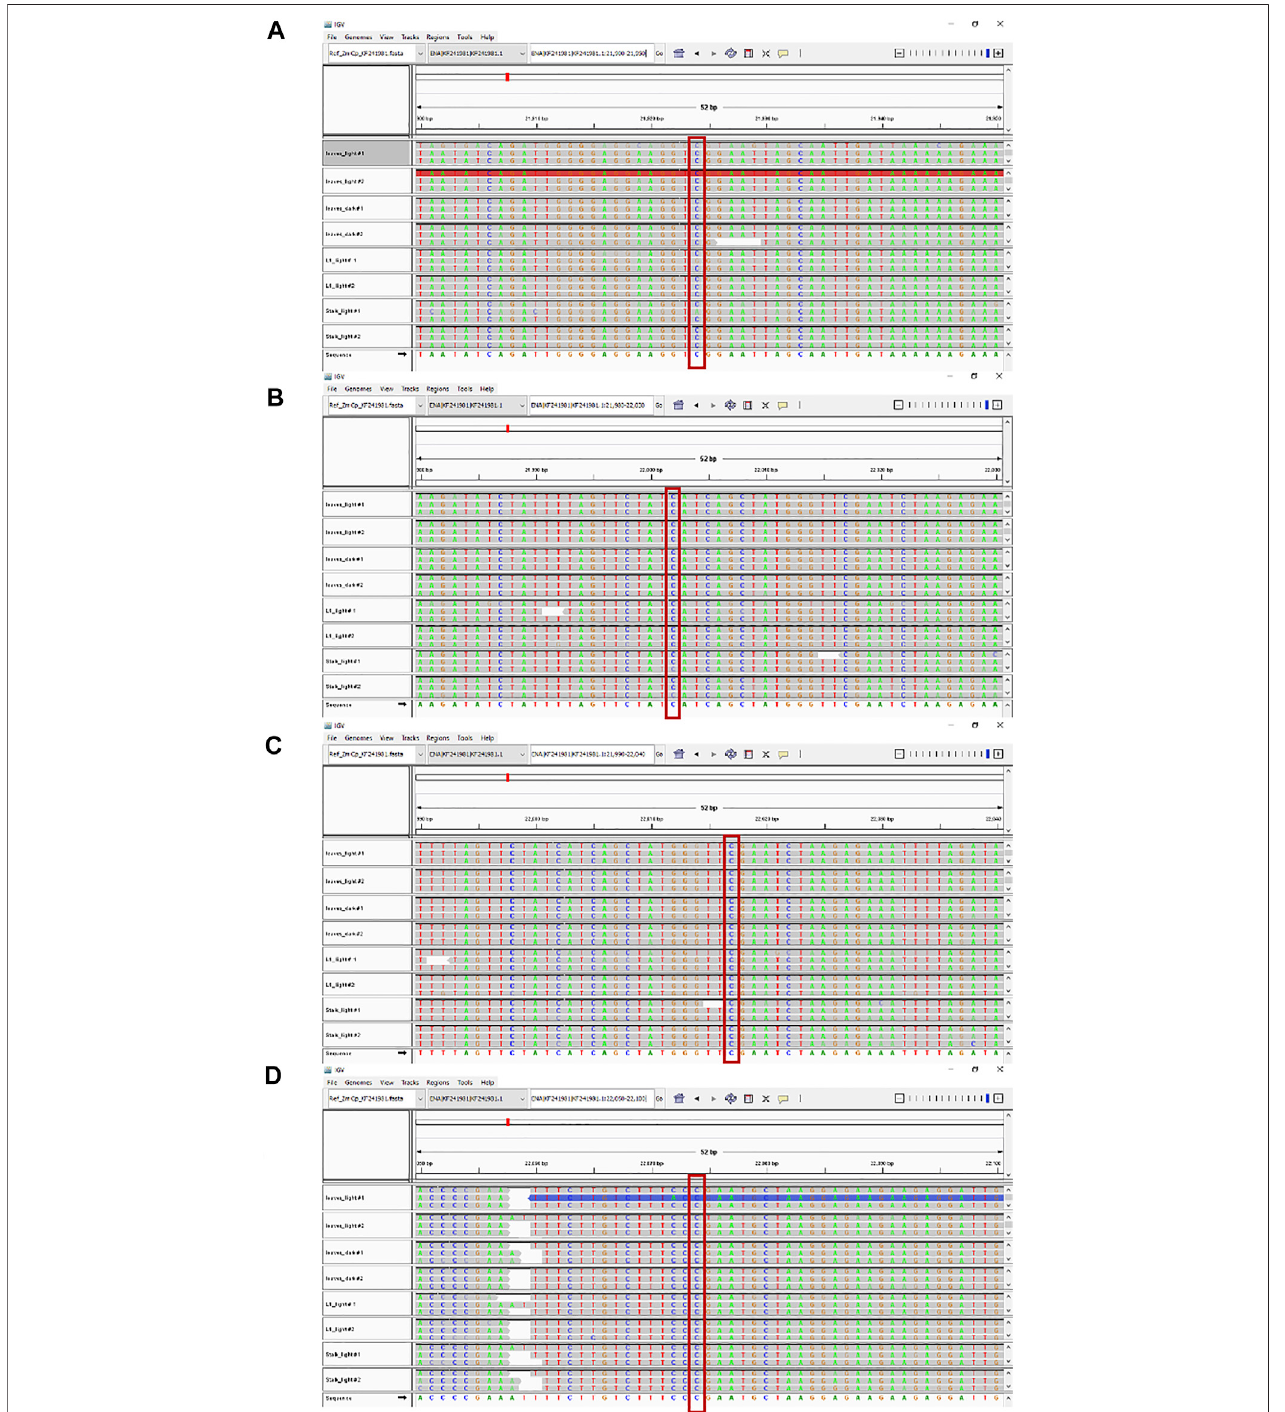
FIGURE 3 | RNA editing sites within the rpoB gene. Maize ptDNA sequences from four tissues were aligned against the rpoB gene of the B73 plastid reference genome (NCBI # KF241981.1) using the Integrative genome browser (IGV). Comparison of sequences around four RNA editing sites are shown and located at nts (A) 21924, (B) 22002, (C) 22017, and (D) 22074, respectively. The conserved RNA editing sites are shown in red boxes.